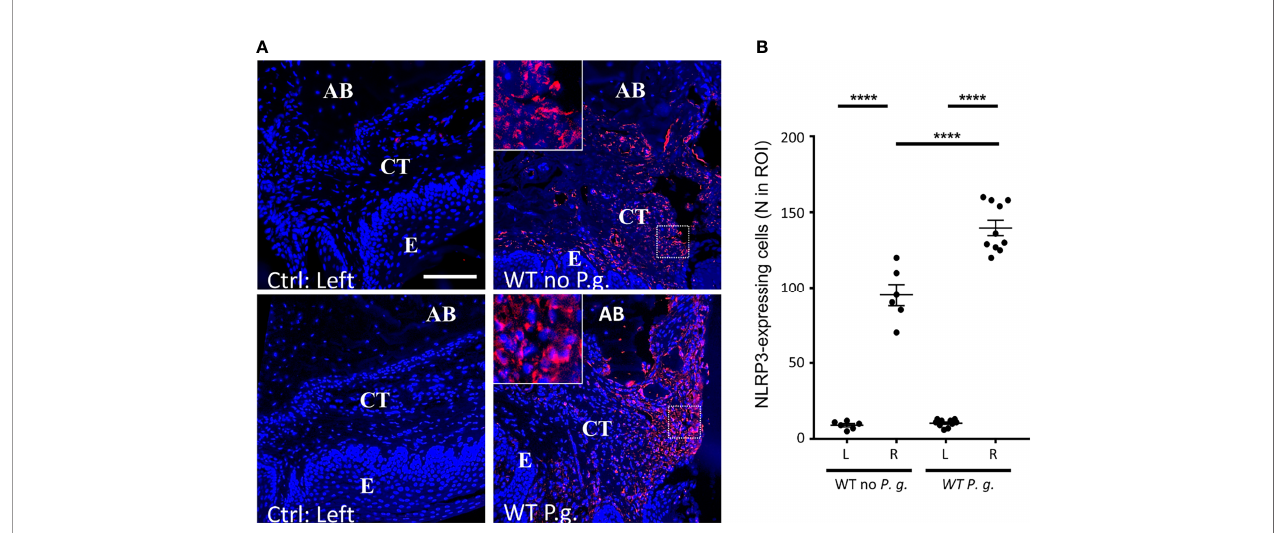
FIGURE 5 | NLRP3 is overexpressed in periodontitis connective tissue of WT mice. (A) NLRP3 protein expression was revealed by immuno fl uorescence. The control without periodontitis induction (left side) are shown on the left panels, the assays with ligature with or without P. gingivalis (right side) are shown on the right panels. The square enlargement helps to visualize individual cells along alveolar bone. (CT = connective tissue, AB = alveolar bone, E = epithelium), scale bar = 100 m m. (B) The number of NLRP3-expressing cells in a standardized ROI (ROI = 0.082 mm 2 ) was quanti fi ed. Each dot represents a single mouse. Horizontal bars represent the mean +/- SEM. Ordinary one-way ANOVA followed by uncorrected Fisher ’ s LSD with a single pooled variance multiple comparison test. ****P <